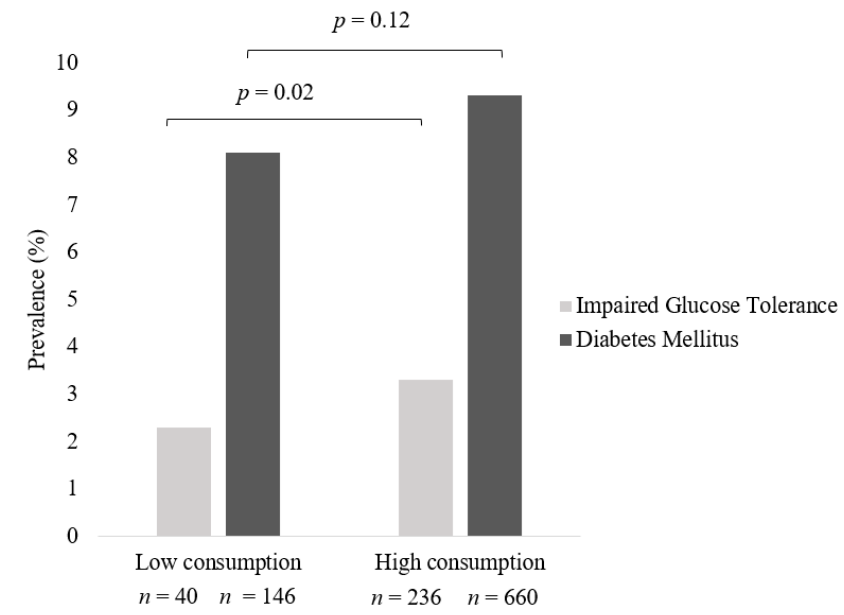
Figure 2. Prevalence of IGT and Diabetes across frequency of meat intake in All Meat Eaters in Australian women from the Australian Longitudinal Study on Women’s Health. Pearson chi-square test was used to compare prevalence of disease across groups. Data are presented as percentages. Low consumption encompasses individuals who consumed meat ≤ 1/week up to but less than daily and high consumption those who consumed meat daily/multiple times per day.